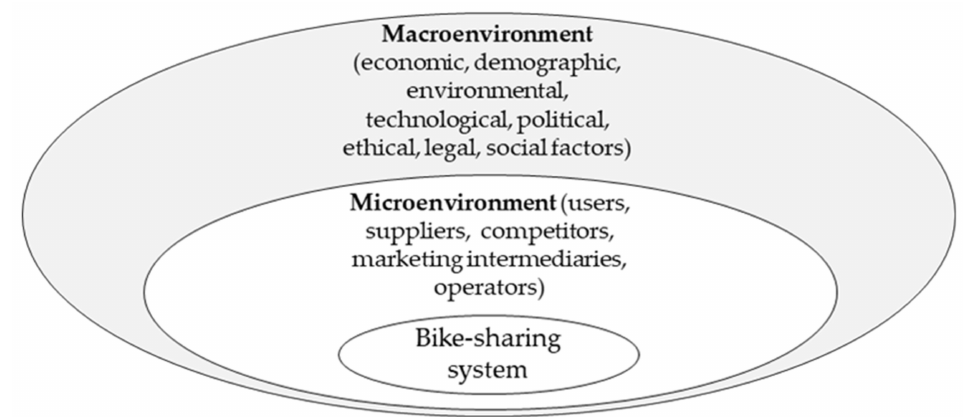
Figure 1. Micro- and macro-environmental factors of the bike-sharing